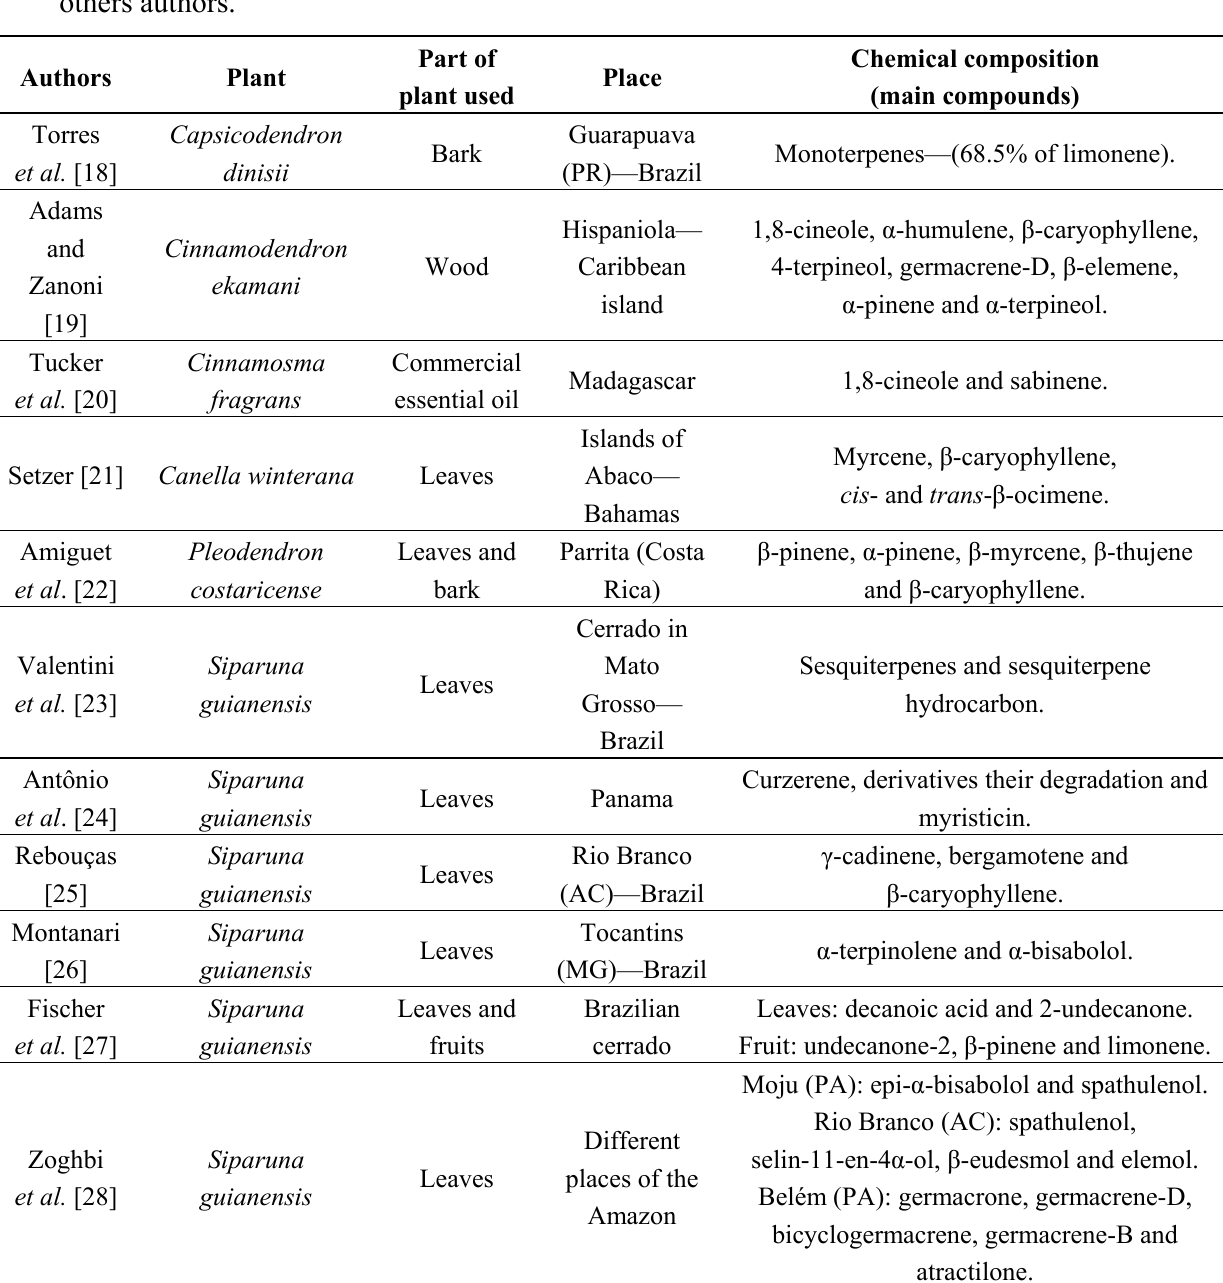
Table 2. Chemical composition of the essential oils obtained from different plant parts of species of the Canellaceae family and of the Siparuna guianensis specie found by others